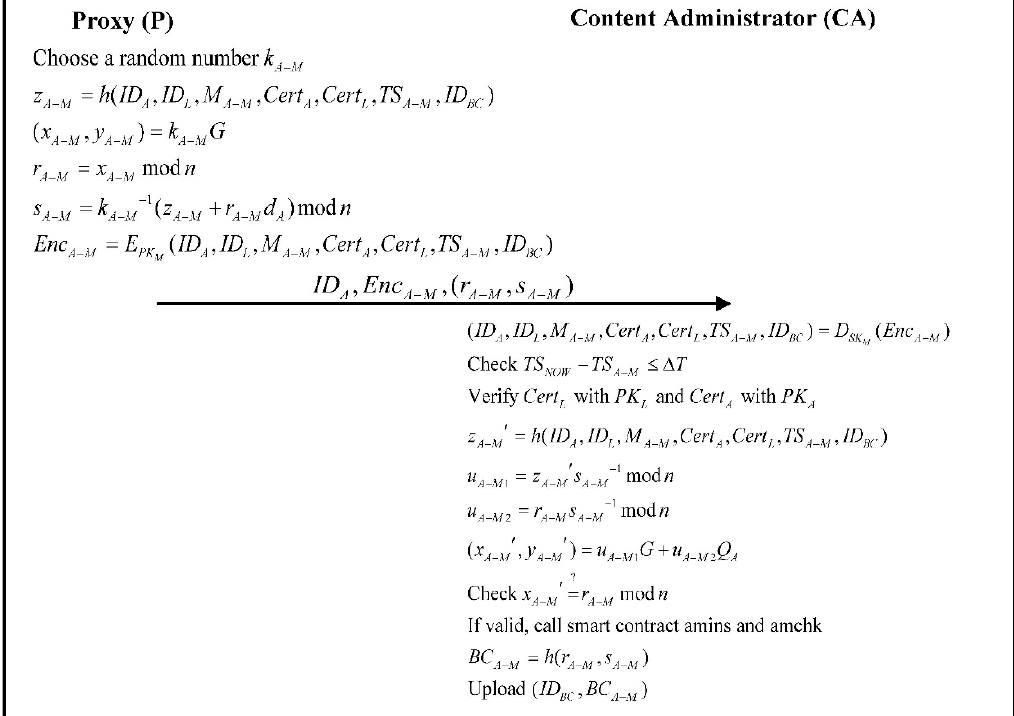
Figure 8. Authentication and issuing invoice phase (P to CA).